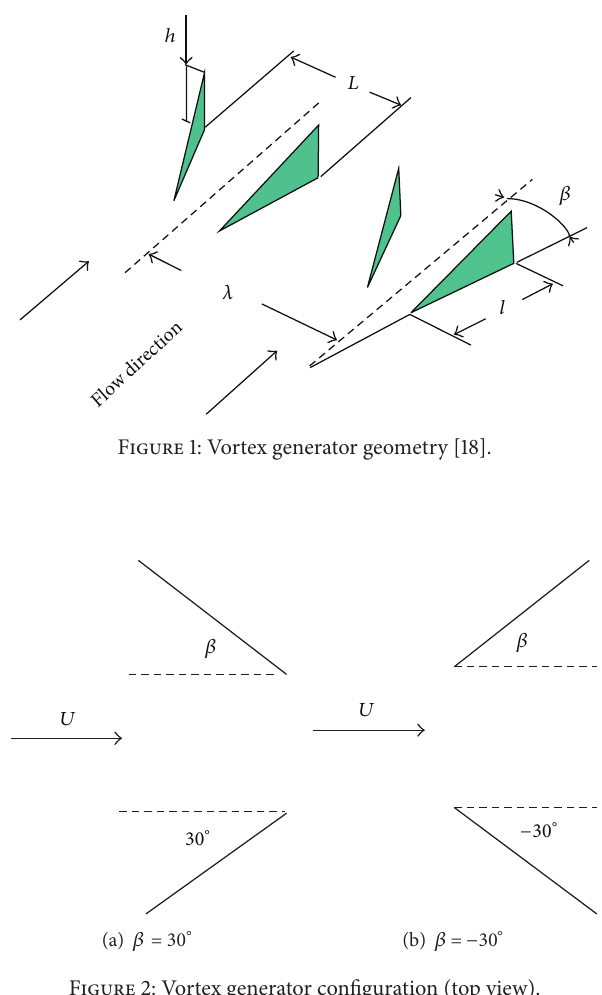
Figure 2: Vortex generator configuration (top